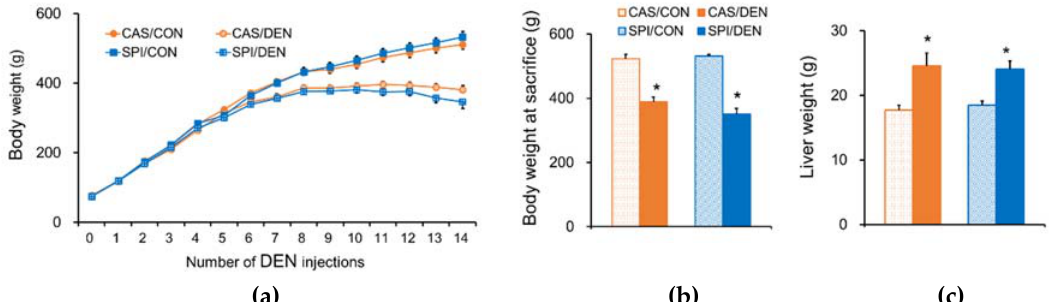
Figure 2. E ff ects of maternal diet on body weights in DEN-treated male rat o ff spring. ( a ) Body weight changes during DEN injection period. From four weeks of age, male o ff spring started to receive weekly intraperitoneal injection of DEN at 50 mg / kg. Body weights were measured weekly on the day of DEN or saline injection. ( b ) Body weight and ( c ) liver tissue weight at sacrifice. Results are expressed as means ± SEM ( n = 6 − 10 / group). * Significantly di ff erent from the maternal diet-matched control (CON) group at p < 0.05 (one-way ANOVA with Duncan’s multiple comparison test).